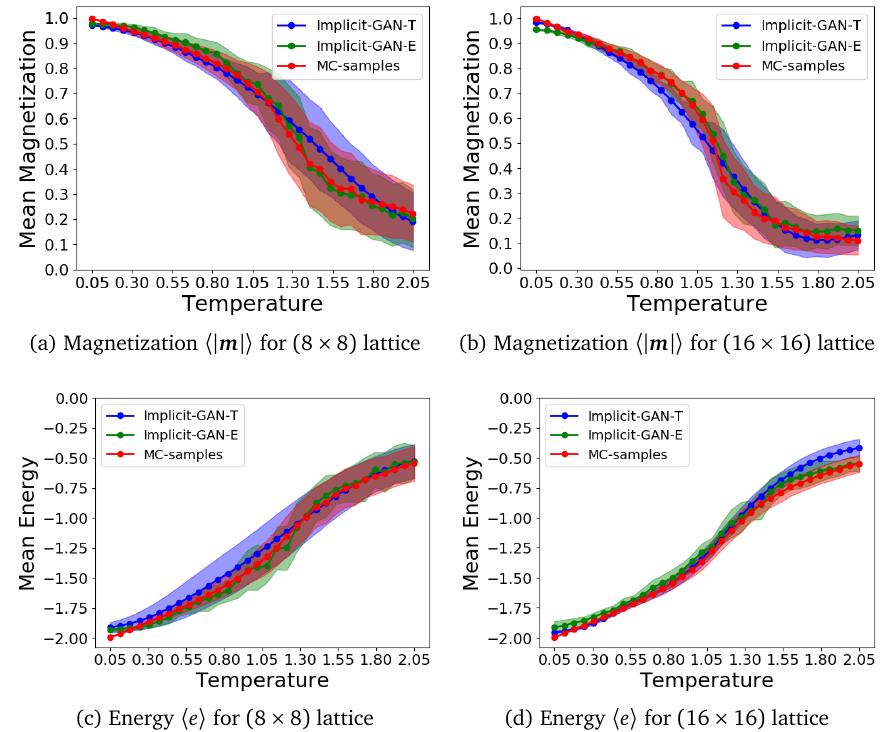
Figure 4: Comparison of energy-conditioned models integrated with MCMC and temperature-conditioned (direct sampling) models with ground truth (MC samples). Symbols and lines indicate average values and shaded portion the standard deviation of the corresponding observable as a function of